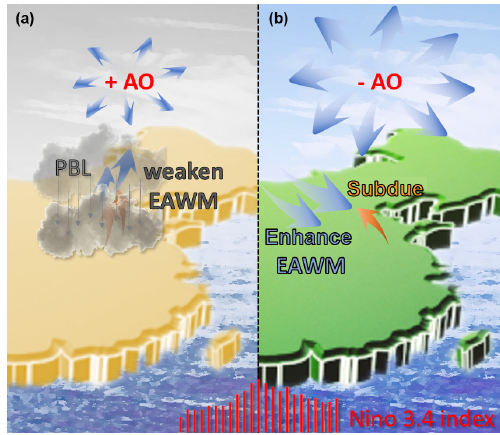
Figure 9. Schematic of the modulation of El Niño and Arctic Os- cillation on atmospheric circulation and haze in northern